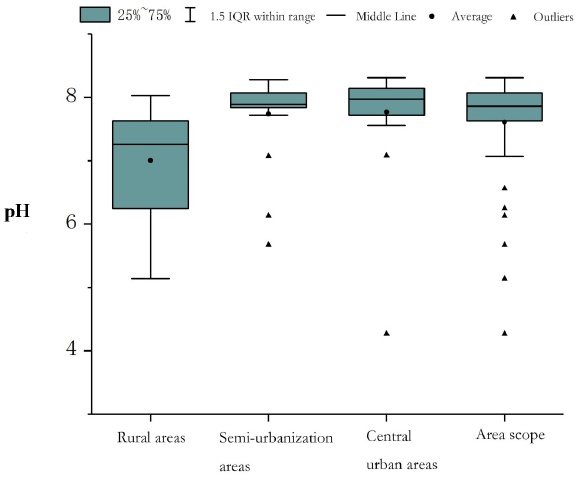
Figure 3: pH of different soil